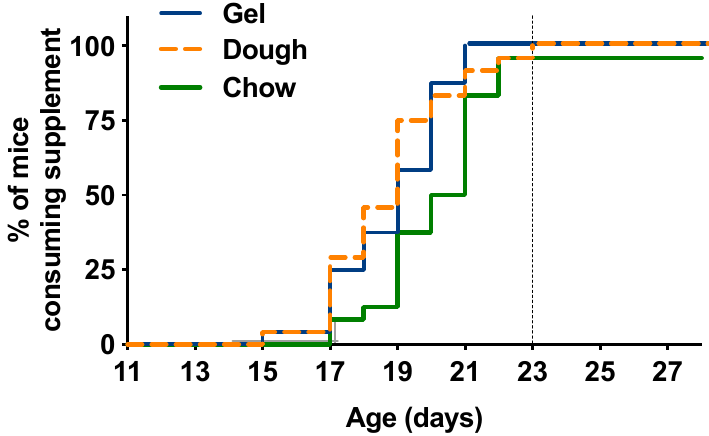
Figure 4. Kaplan–Meier time to event (supplement utilization) curve, by supplement group. Dough and Gel supplements were consumed earlier than Chow ( p = 0.0091). The majority of animals ( > 95%) were consuming the supplement by day 23, indicated by the dotted